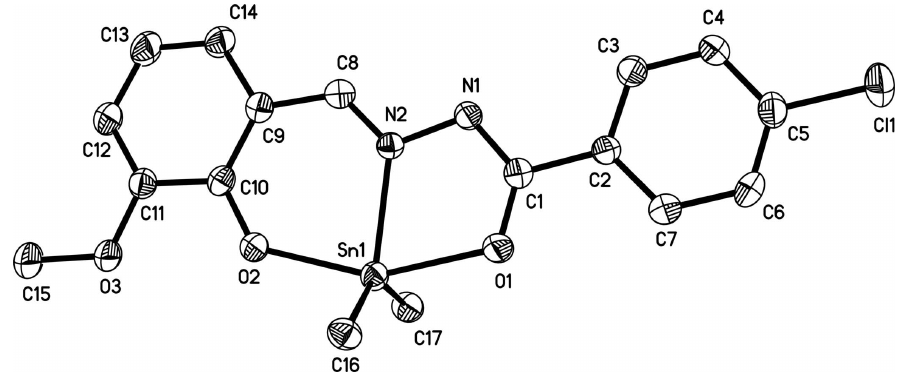
Figure 1 The molecular structure of (I), showing 30% probability displacement ellipsoids and the atom-numbering scheme. H atoms have been omitted for